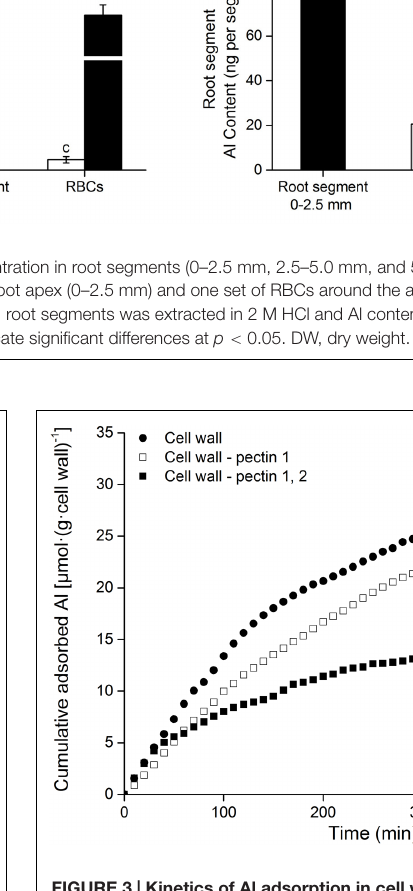
FIGURE 3 | Kinetics of Al adsorption in cell wall materials of RBCs. The adsorption of cell wall materials was carried out using mini-column chromatography. Al content in the eluates was measured colorimetrically using pyrocatechol violet. The experiment was repeated at least three times with the same